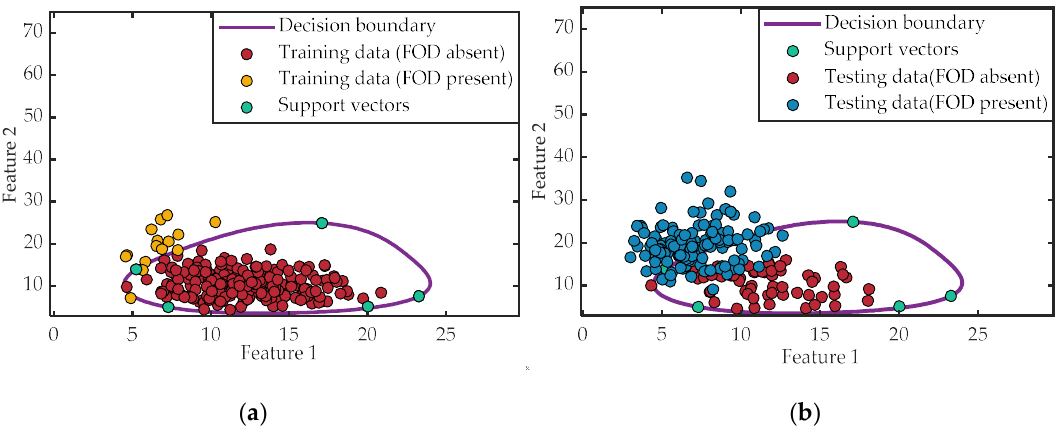
Figure 8. Detection results with the PSO-NSVDD: ( a ) training procedure and ( b ) testing procedure.